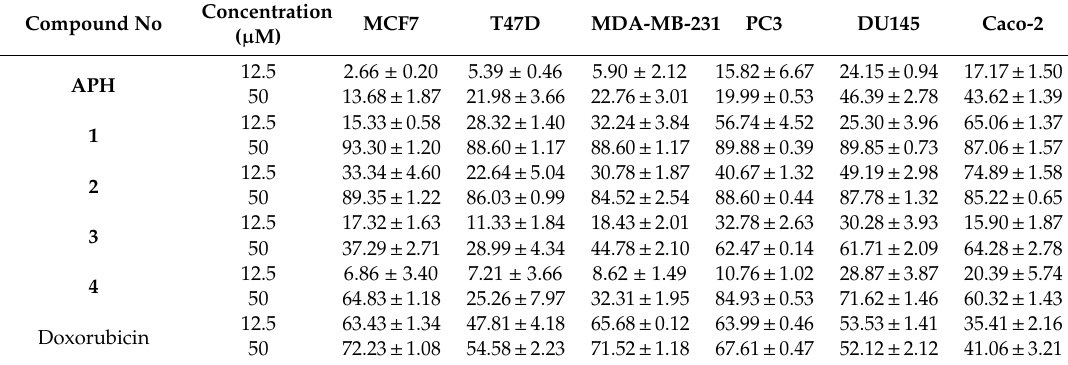
Table 4. The e ff ect of newly synthesized complexes 1 , 2 , 3 and 4 , derived from adamantyl containing a hydrazine ( APH ) ligand on the viability of six cancer cell lines (MCF7, T47D, MDA-MB-231, PC3, DU145, and Caco-2) after 72 h of incubation. Doxorubicin is used as a positive control. The data are represented as percentage of growth inhibition ±